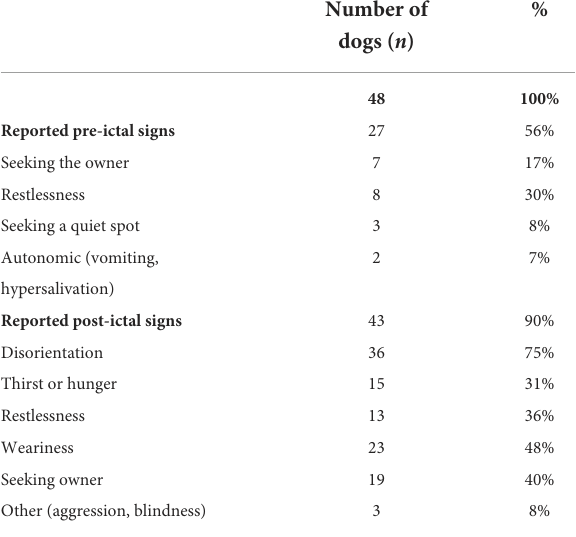
TABLE 3 Reported pre- and post-ictal signs in the studied IS